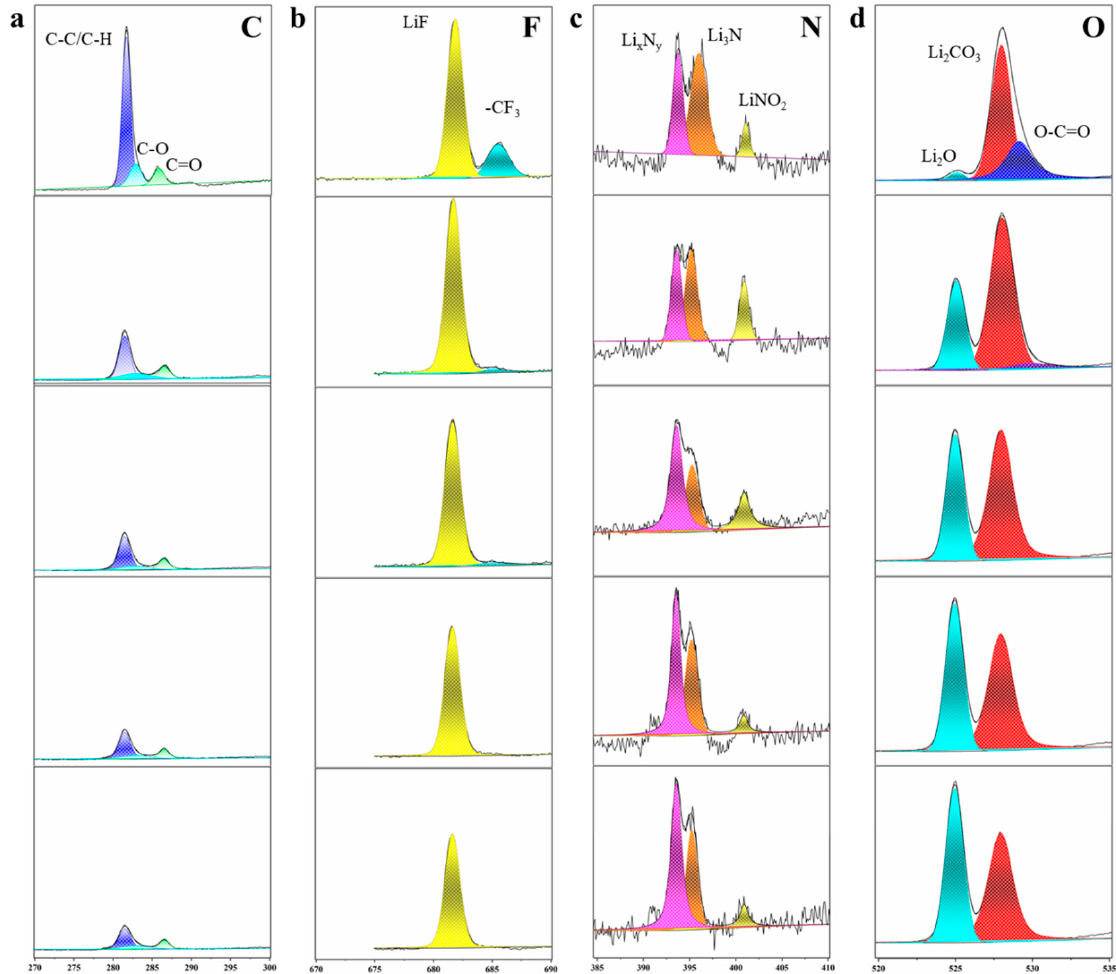
Figure 4. In ‐ situ XPS etching tests for C, F, N, O elements and element content distribution. In ‐ situ XPS etching for ( a ) C, ( b ) F, ( c ) N and ( d ) O elements at 0, 50, 100, 150 and 200 s on lithium metal deposited after modification by FAZ nanospheres.